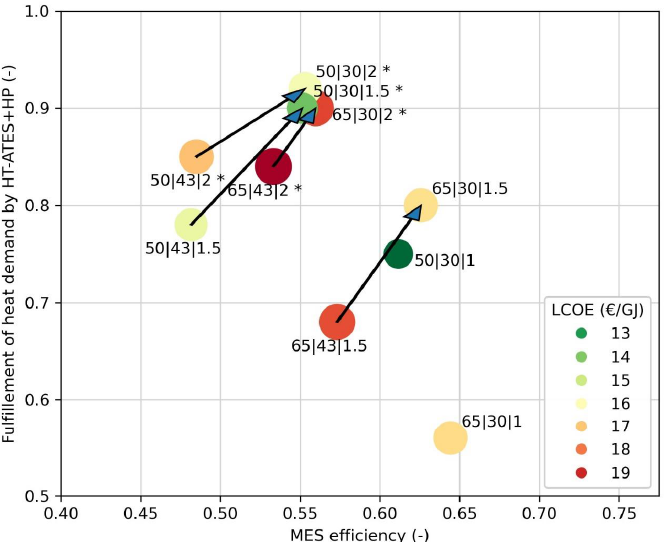
Figure 10. The relationships between the three main aspects investigated in this study; the fulfilment of heat demand by HT-ATES + heat pump to the MES (10-year average), the 10y MES efficiency and the costs of heat production and storage (LCOE). The * added to the scenario code indicates that the HT-ATES can deliver 100% of the heat to the multi-energy system within the first five